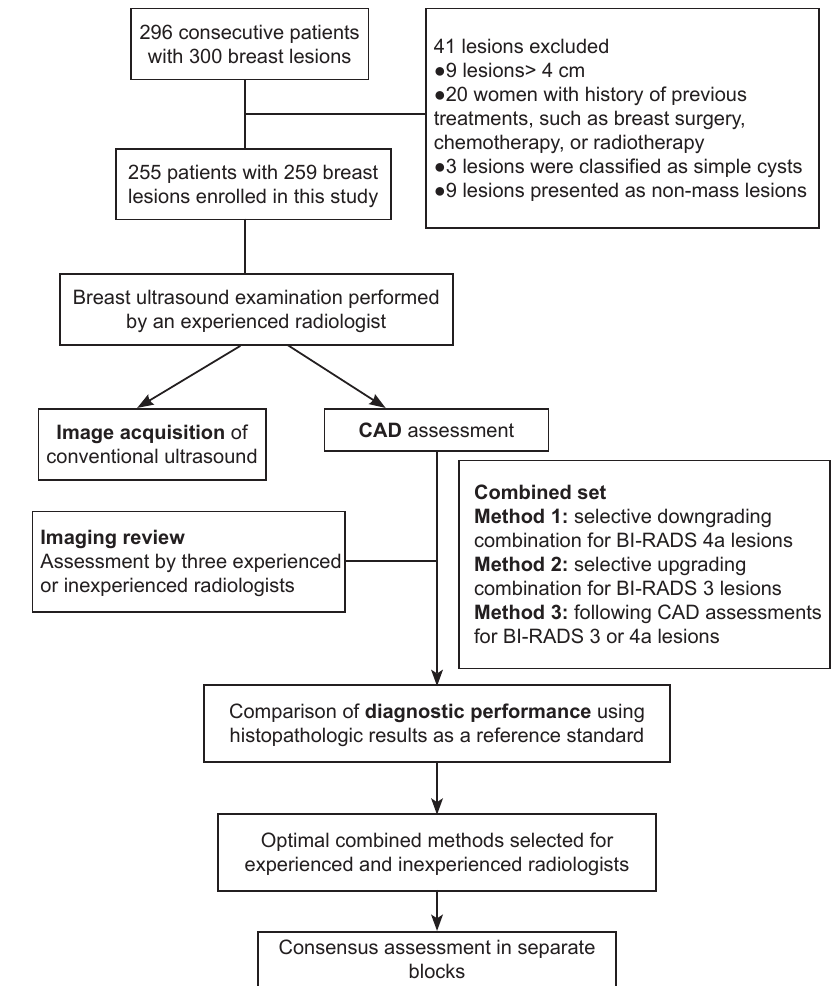
Figure 1 Schematic representation of the study